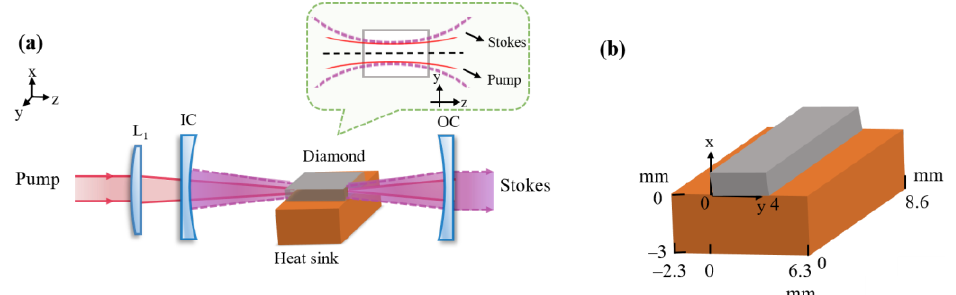
Figure 1. ( a ) Schematic of DRLs used for the simulation. ( b ) Model of the diamond crystal and copper heat sink used for the simulation.